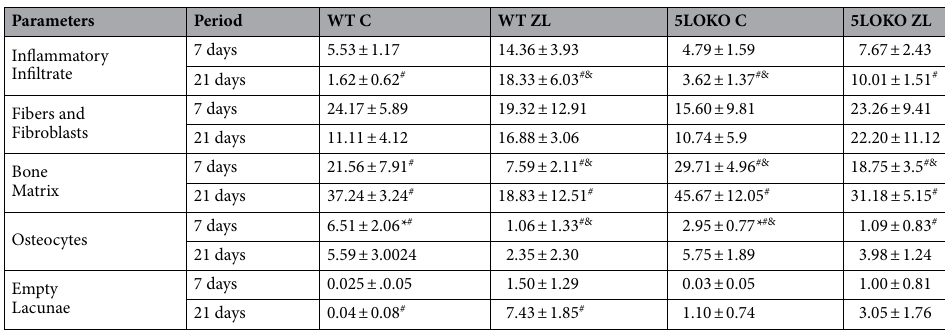
Table 2. Histomorphometry for alveolar bone healing in WT vs. 5LOKO aged female mice treated or not with ZL. Results are presented as the means (± SD) for each parameter. In the comparison between columns, symbol* indicates comparison between the effect of 5LO knockout vs. WT; symbol # indicates the effect of ZL treatment in groups of same genotypes (WT vs. WT ZL); and symbol & indicates the effect of ZL treatment in different genotypes (i.e. WT-ZL vs. 5LOKO-ZL or WT-ZL vs. 5LOKO C ). Statistically significant differences are indicated between groups with equal symbols (p <